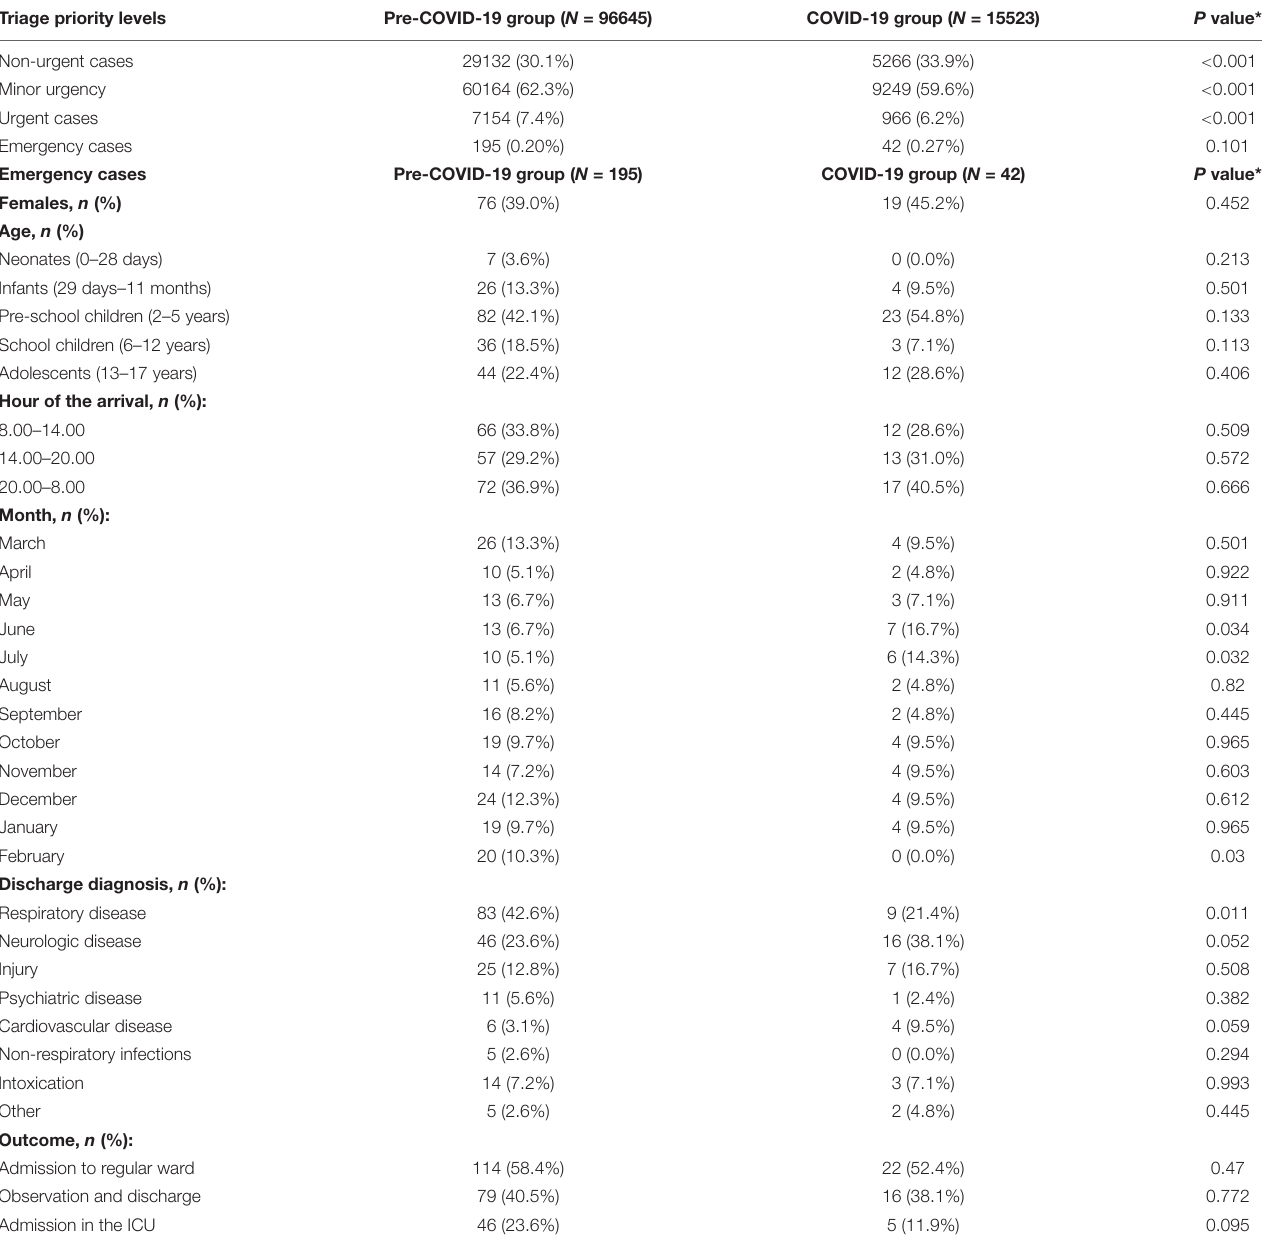
TABLE 1 | Main study